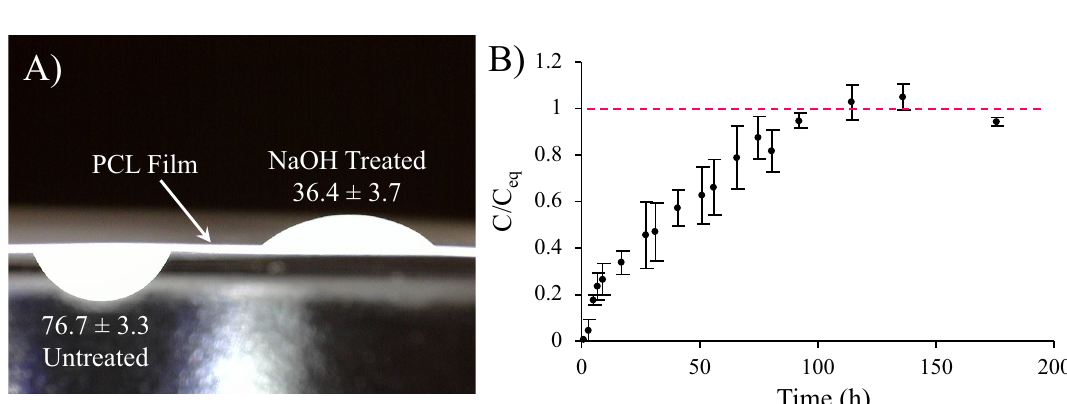
Figure 9. ( A ) The effect of treatment with NaOH on the wettability and contact angle of the PCL Film. ( B ) The diffusion kinetics of the model probe (i.e. fluorescein sodium salt) through the Film ( C concentration, C eq concentration at